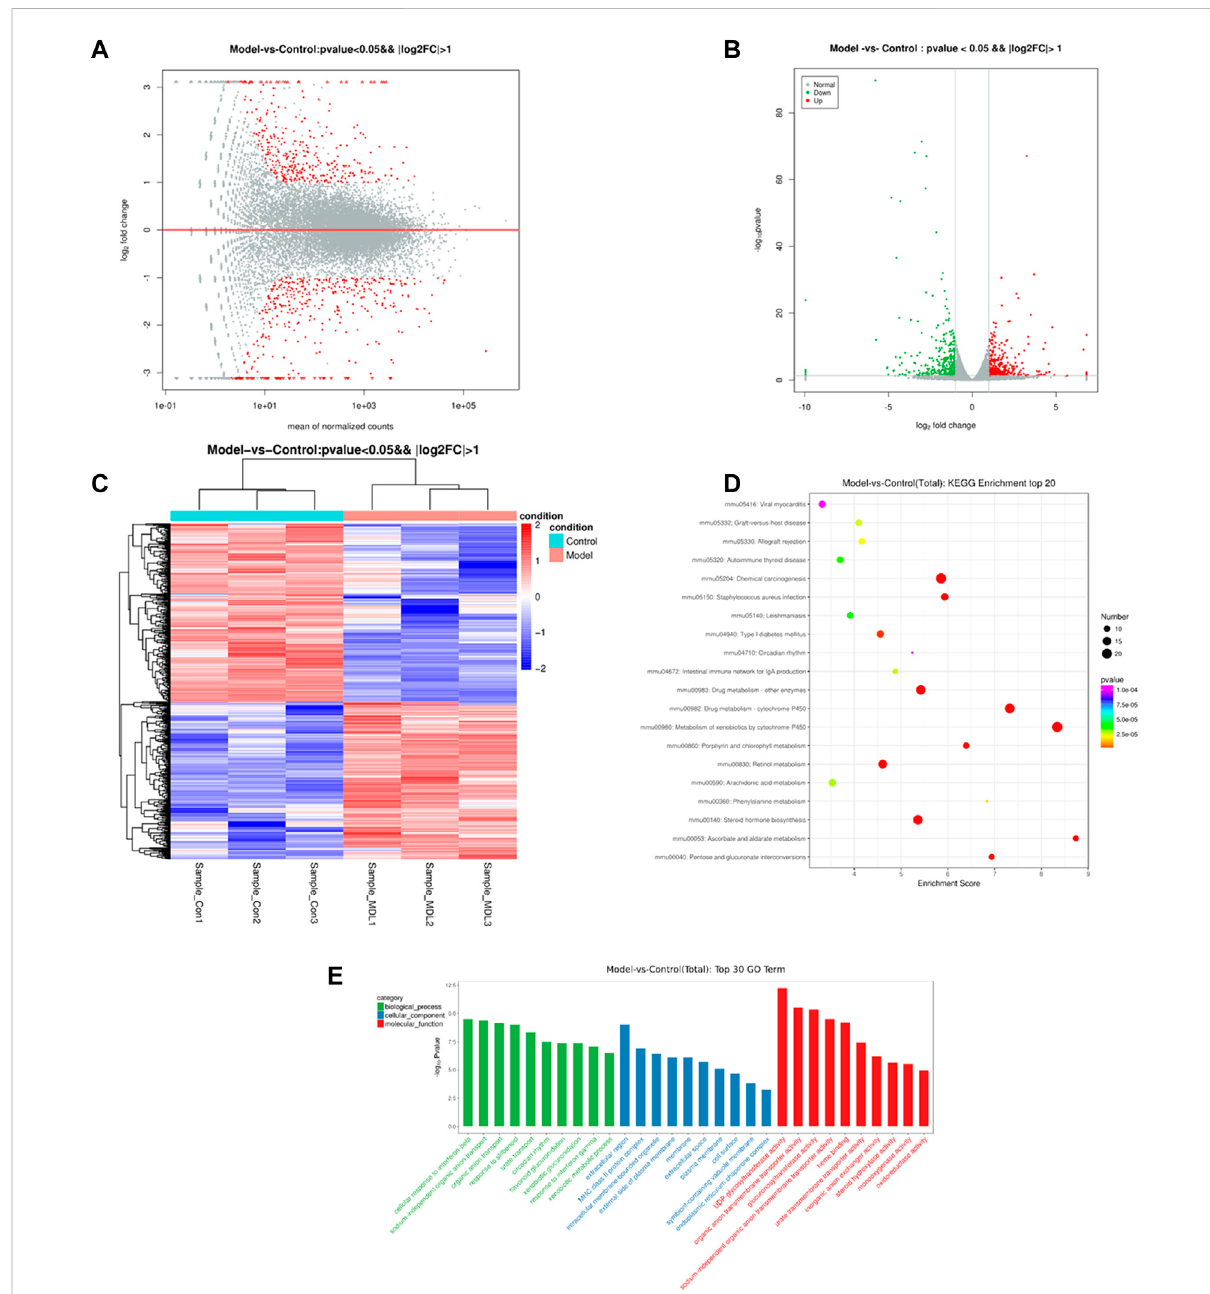
FIGURE 4 The differentially expressed genes in the control and model groups of MA map (A) , volcano map (B) and heat map (C) . Analysis result of GO (D) between the control and model groups. KEGG enrichment (E) of the control and model